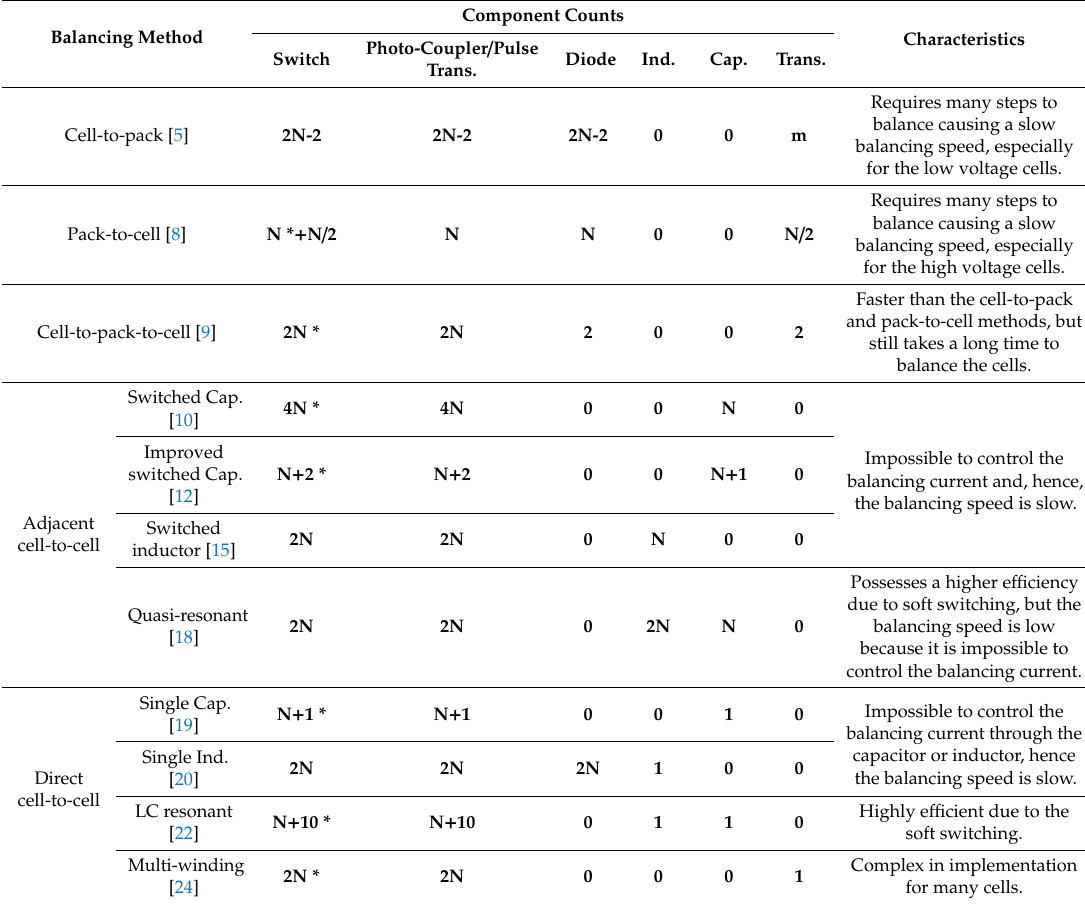
Table 1. Comparison of the balancing